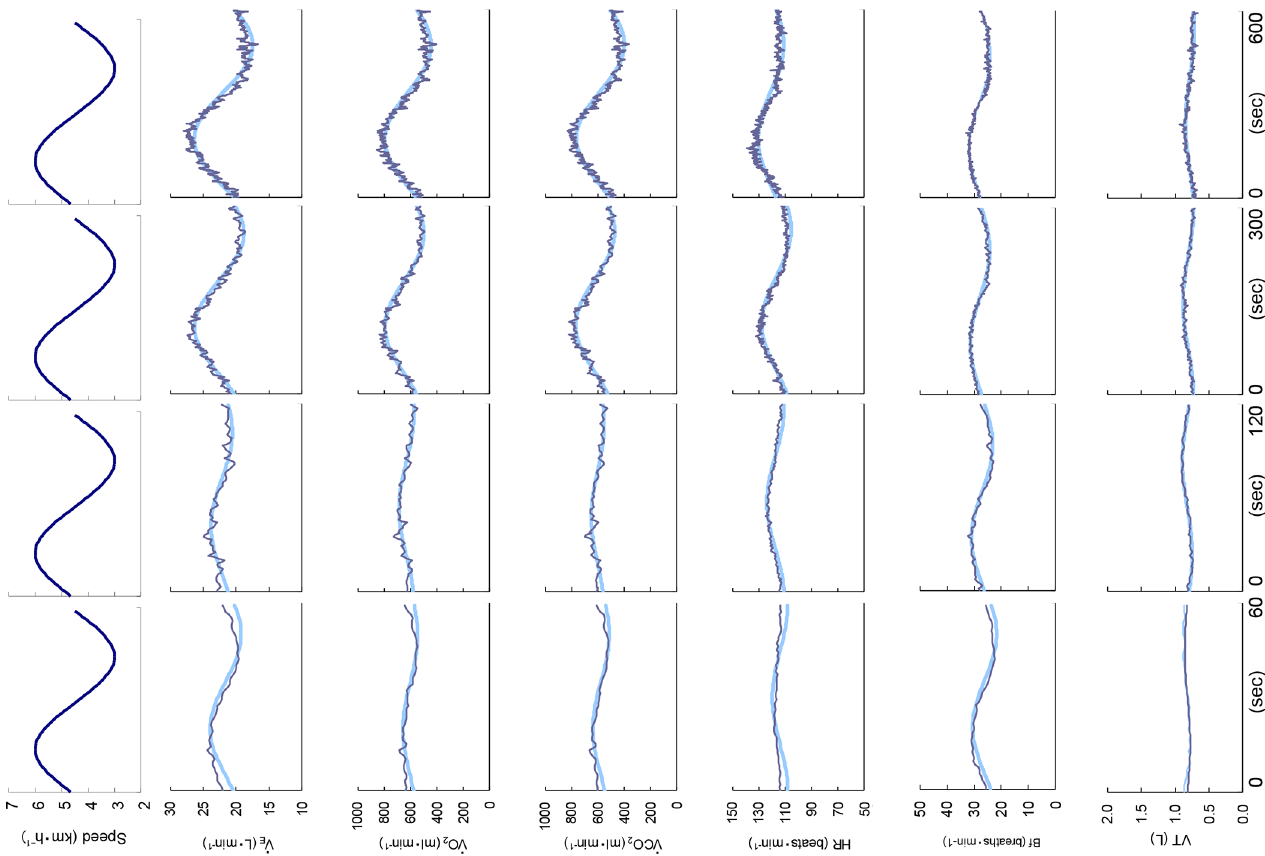
Fig 2. Time course of the ventilatory and gas exchange responses at different periods. The responses of a representative subject’s variables of ventilation ( _ V ), O 2 uptake ( _ VO ), CO 2 output ( _ VCO ), heart rate (HR), tidal volume (VT), and breath frequency (B f ) over four different periods of 1, 2, 5, and 10 min are 2 2 E shown. Oscillating lines: Superimposed data on gas exchange variable. Smooth lines : Fundamental sine-wave component of these kinetics.